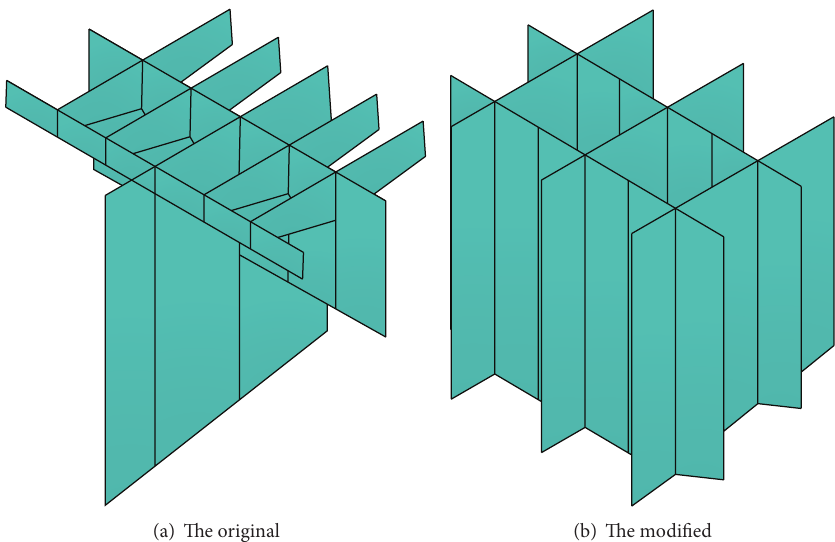
Figure 9: Illustrations of the original and modified internal structural configuration of pedestal.